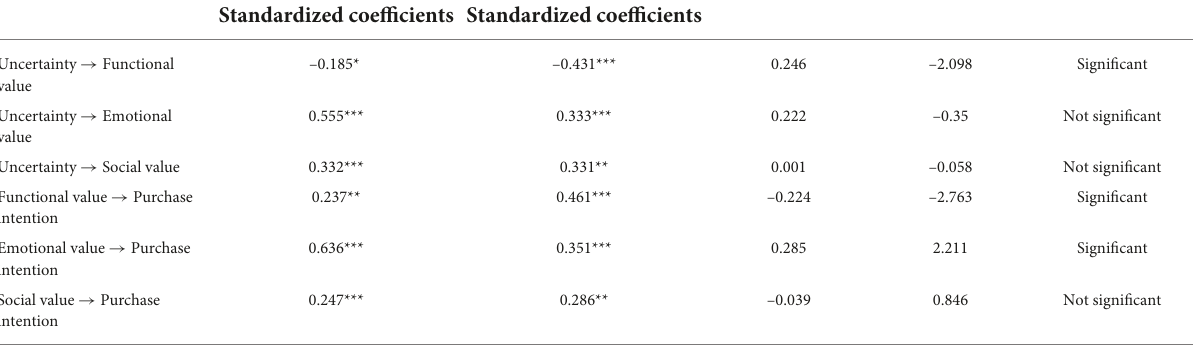
TABLE 7 Moderating effect of consumption